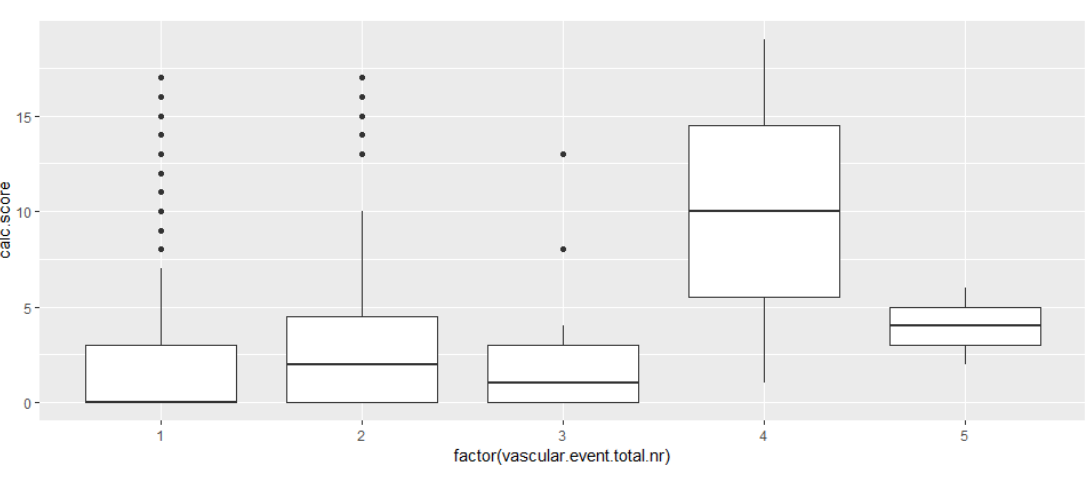
Figure 4. Severity of calcifications in vertebrobasilar arteries represented as calcium score (range 0–19) versus number of total vascular events on x-axis (prior stroke / TIA, index stroke, recurrent stroke / TIA, myocardial infarction, heart failure, peripheral arterial occlusive disease) in 448 patients hospitalized due to ischemic stroke and followed-up up to 7 years (Kruskal–Wallis P = 0.012).